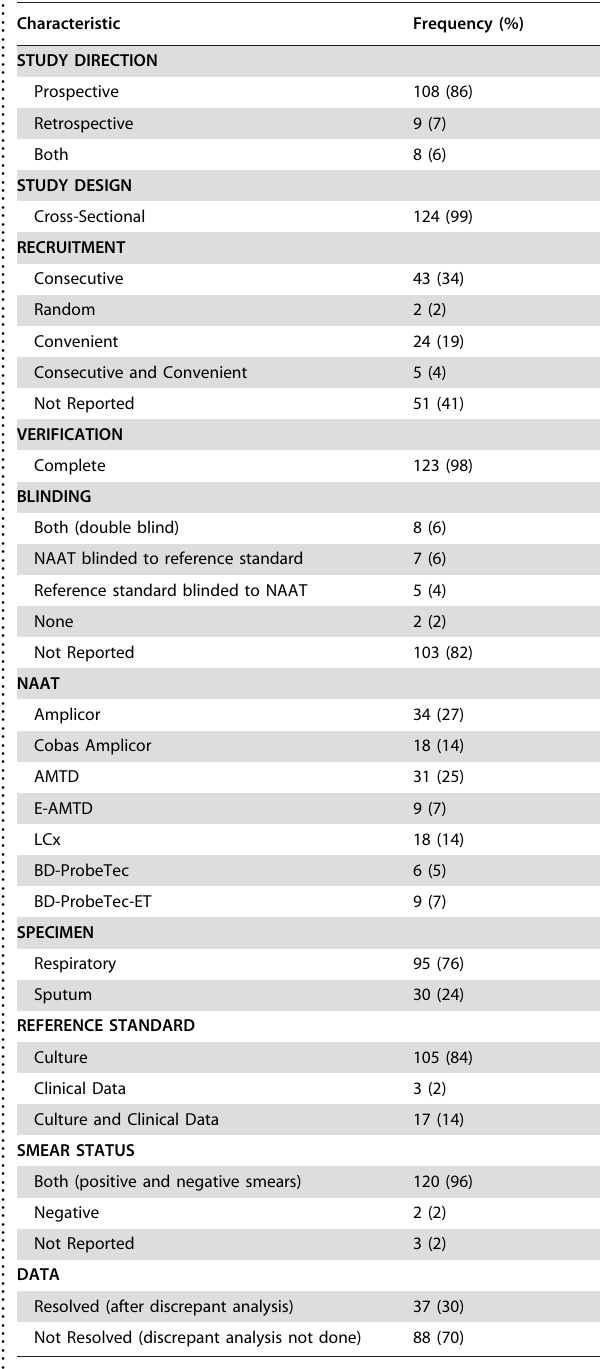
Table 2. Characteristics of NAAT Studies Included in